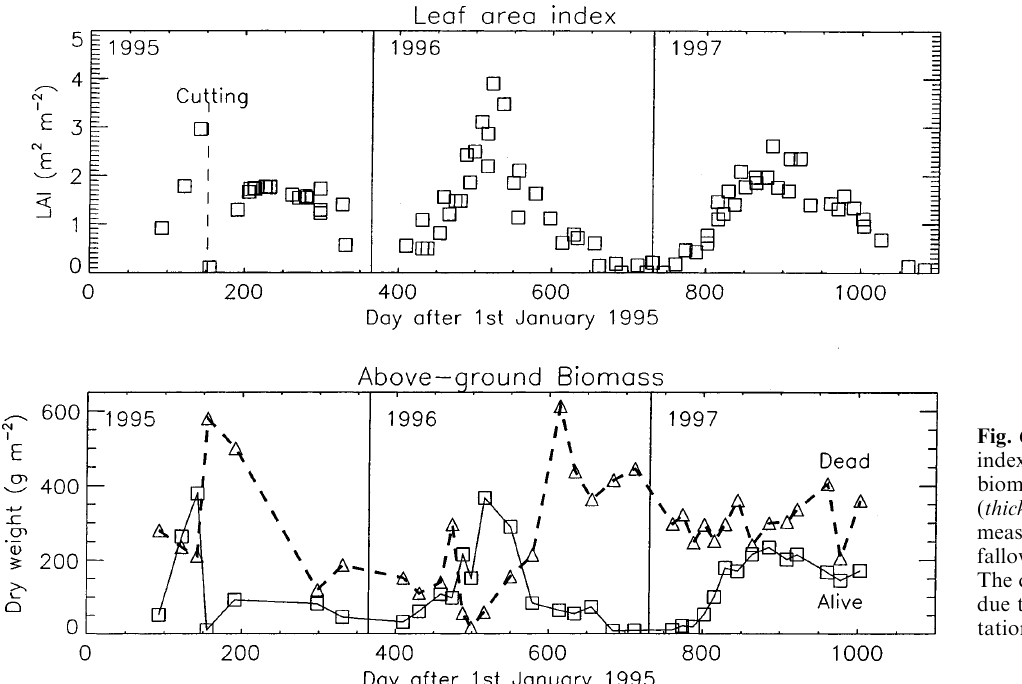
Fig. 6. The green leaf area index and above-ground green biomass ( boxes ) and necromass ( thick dashed line and triangles ) measured over the MUREX fallow in 1995, 1996, and 1997. The discontinuity on day 152 is due to the cutting of the